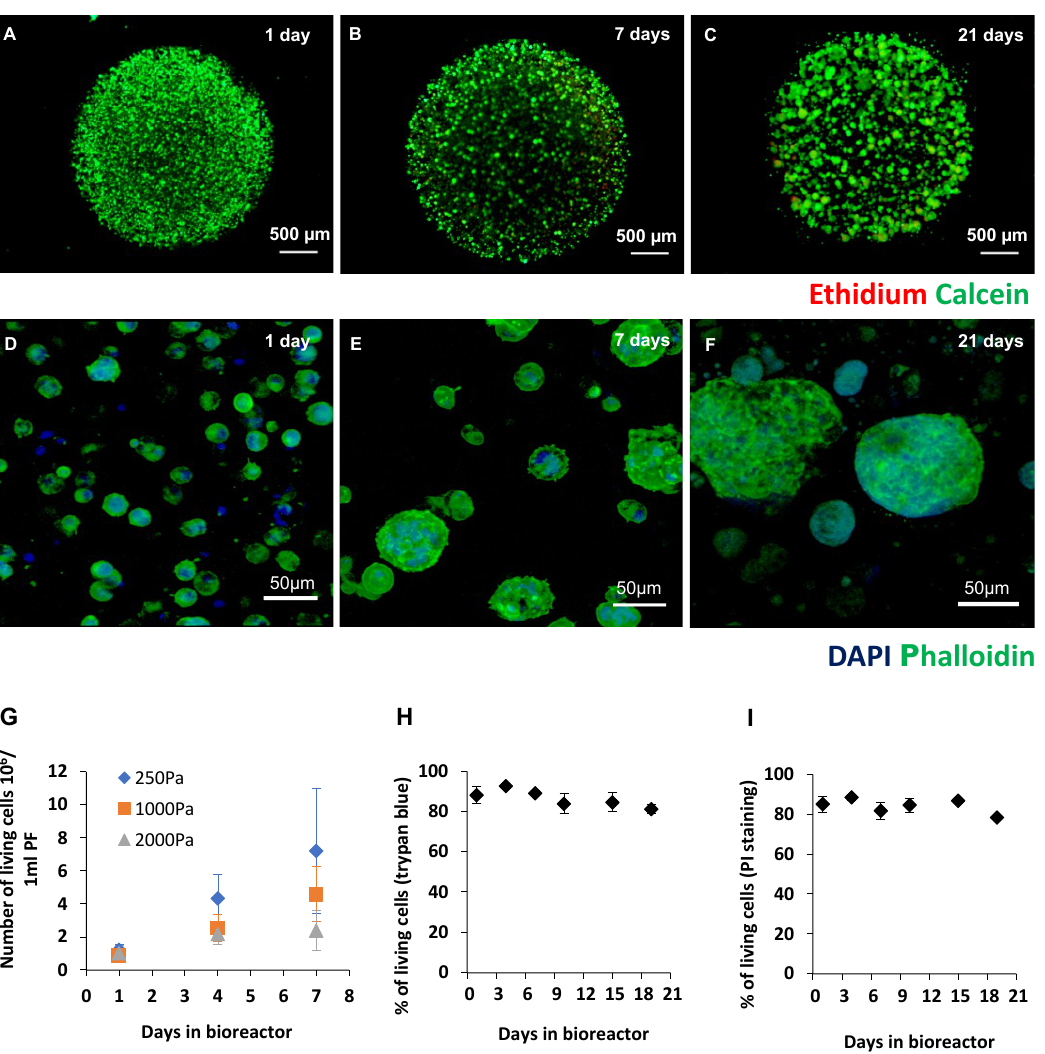
Figure 2. Viability of HEK293 cells within PF microcarriers in 3D culture. ( A – C ) Cell viability of HEK293 cells growing in the 3D PF microcarriers (8 mg/mL, G’ = 250–2000 Pa) in bioreactors was verified using a calcein/ethidium assay. Initially, viable cells were distributed uniformly in the microcarriers on day 1 ( A ) and organized into colonies by day 7 ( B ), remaining viable beyond day 21 ( C ). High-magnification images of cells stained with f-actin FITC-phalloidin (green) and DAPI (nucleus in blue) show the cells initially distributed uniformly within the microcarriers on day 1 ( D ). After 7 and 21 days, the cell colonies were also distributed uniformly throughout the microcarrier ( E , F ). ( G ) The number of living cells was quantified in the microcarriers as a function of culture time (up to 7 days) and PF modulus (G’ = 250–2000 Pa). The G’ values shown in the graph correspond to the PF hydrogels made from different formulations, as determined based on data provided in Supplementary Figure S1. As can be seen, both PF modulus and culture time affected the number of HEK293 cells in the microcarriers. ( H ) Cell viability over 21 days in PF microcarriers (G’ = 1000) with suspension culture, as measured by a trypan blue exclusion assay. Each time point represents data from an average of several bioreactors (3 < n < 18). ( I ) Cell proliferation in PF microcarriers (G’ = 1000) with suspension culture in bioreactors for up to 21 days, as measured by a PI staining assay; each time point is represented by an average of at least three different experiments ( n > 3). All results shown are as mean ± S.D. of at least three independent experiments. The number of living cells in the microcarriers was quantified and shown to increase relative to the culture duration and the mechanical properties of the PF matrix (Figure